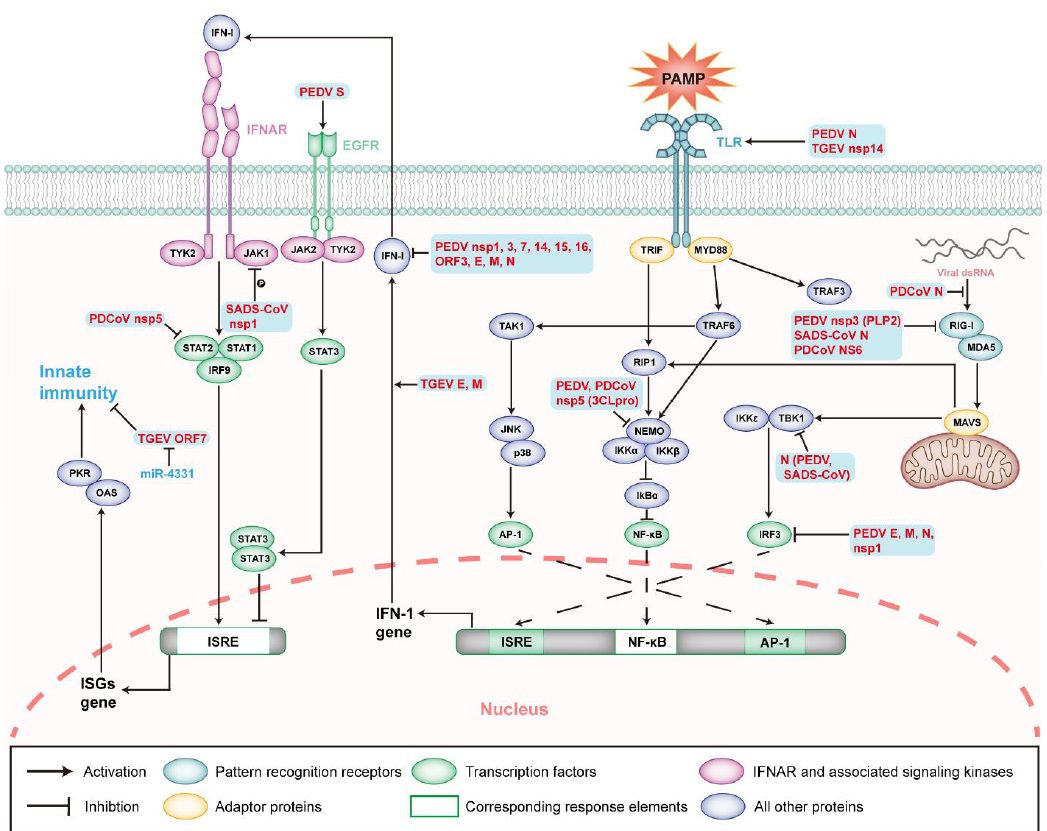
Figure 6. Innate immunity during SeCoV infection and modulatory mechanisms. Schematic dia- gram showing the type I interferon-induced innate immunity signaling pathways and known mod- ulatory mechanisms during SeCoV infection. The viral or viral components involved in the modu- lation of apoptosis are shown in bold red in the figure. Abbreviations: PKR, protein kinase RNA- activated; OAS, 2′5′ -oligoadenylate synthetase; ISRE, interferon-stimulated response element; AP- 1, activator protein 1; TRIF, TIR domain-containing adaptor inducing interferon-beta; RIP1, recep- tor-interacting serine/threonine kinase 1; IKK, IkappaB-kinase; and IκBα, NF- κB inhibitor alpha .